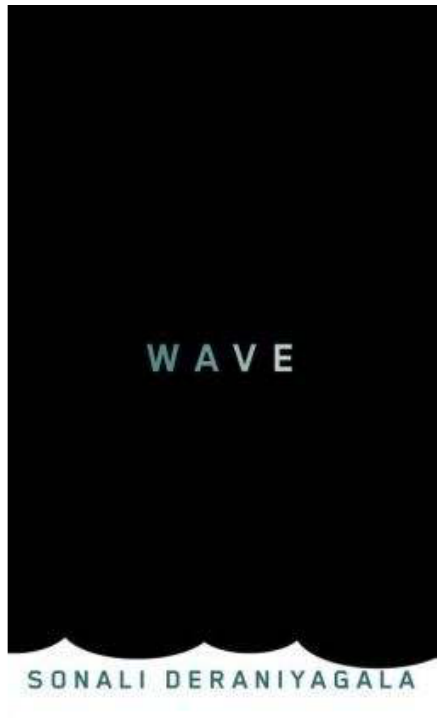
Figure 1. Cover of Sonali Deraniyagala’s Wave